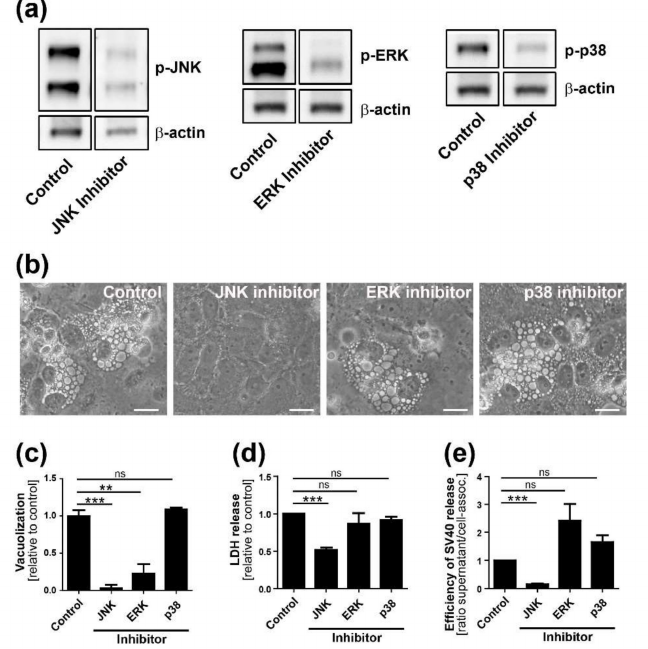
Figure 6. MAP kinase components are required for e ffi cient vacuolization, cell lysis, and virus release. ( a ) Inhibitors SP600125, Selumetinib, and SB203580 inhibit SV40-induced phosphorylation of JNK, ERK, and p38, respectively. CV-1 cells were infected at an MOI of 10. Inhibitor treatment was started at 12 h.p.i., and immunoblotting was performed on extracts prepared 48 h.p.i; ( b ) Bright-field images of CV-1 cells 48 h.p.i. after infection with SV40: CV-1 cells were infected at an MOI of 10 and treated with inhibitors against JNK, ERK, and p38 or DMSO vehicle at 12 h.p.i.. Scale bar, 20 µ m; ( c ) The number of vacuolated cells two days after infection was quantified and normalized to DMSO-treated control cells. *** p < 0.001 and ** p < 0.01; ( d ) Analysis of cell lysis two days postinfection with SV40 in CV-1 cells treated with inhibitors: LDH activity in the supernatant was measured. *** p < 0.001; ( e ) The ratio of released SV40 in supernatant versus cell-associated SV40 is shown. Data were normalized to DMSO-treated control infected cells. Quantitation of cell-associated SV40 and SV40 in the supernatant 48 h.p.i. of CV-1 cells treated with JNK, ERK, and p38 inhibitors is shown in Supplemental Figure S2. The mean values ± SEM from three independent experiments are shown. *** p <